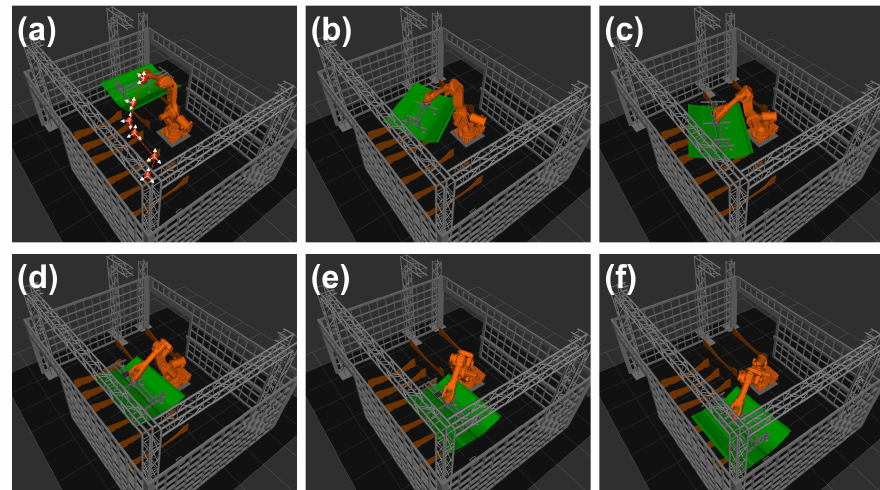
Figure 7. Transport path generated by using the Resolved Motion method in Section 3.1 with user selected waypoints. ( a ) The user specifies a series of waypoints; from ( b – f ), the robot follows through the path generated by the input waypoints.